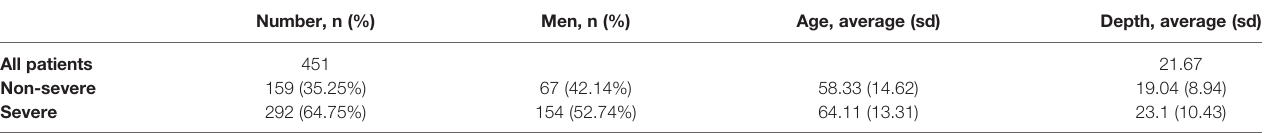
TABLE 1 | Participant